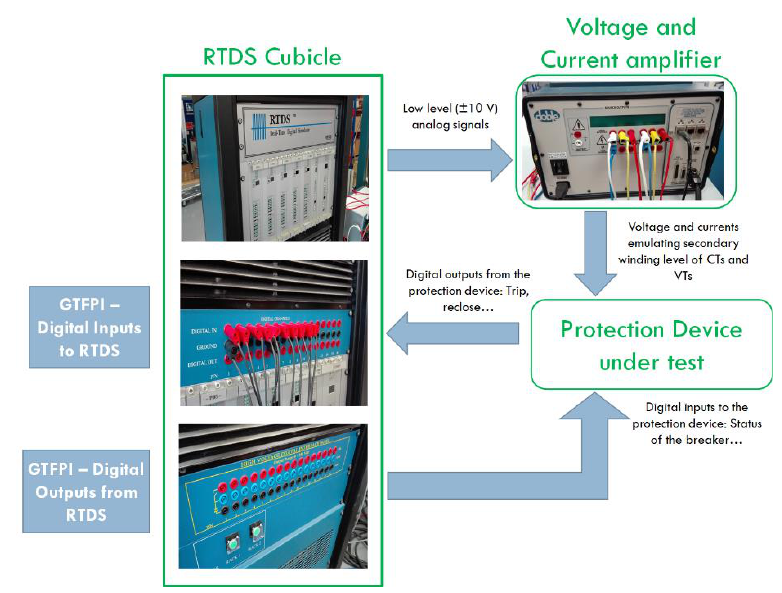
Figure 1. Hardware in the loop testing. Laboratory test-bench and signals exchanged.